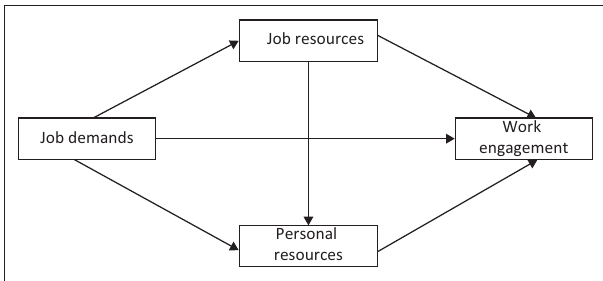
FIGURE 1: Conceptual model: The influence of job demands on work engagement mediated by job resources (employer respect and employee care) and personal resources (PsyCap and